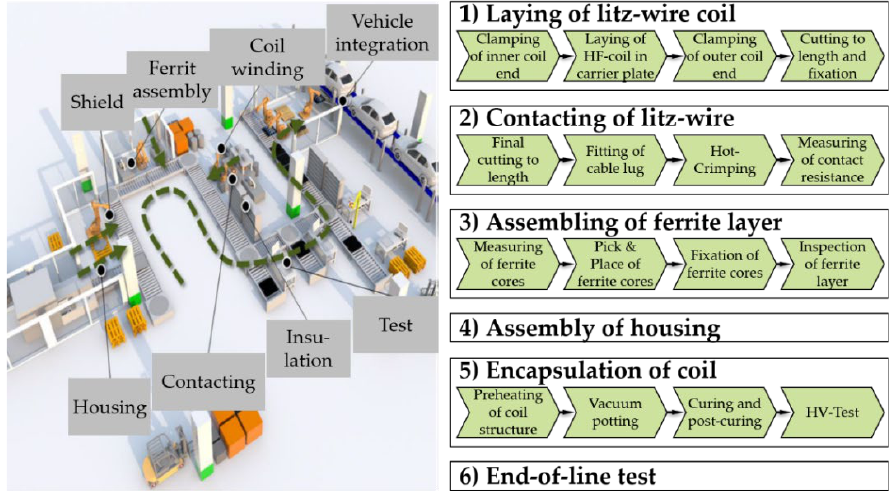
Figure 4. CAD model of a value-added chain [21] ( left ) and process chain of the IPT pad production ( right ).